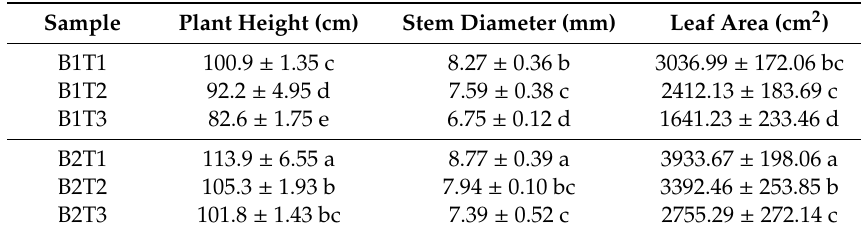
Table 1. The influence of di ff erent nutrient solution irrigation treatments and downy mildew infection on growth parameters of cucumber plants.